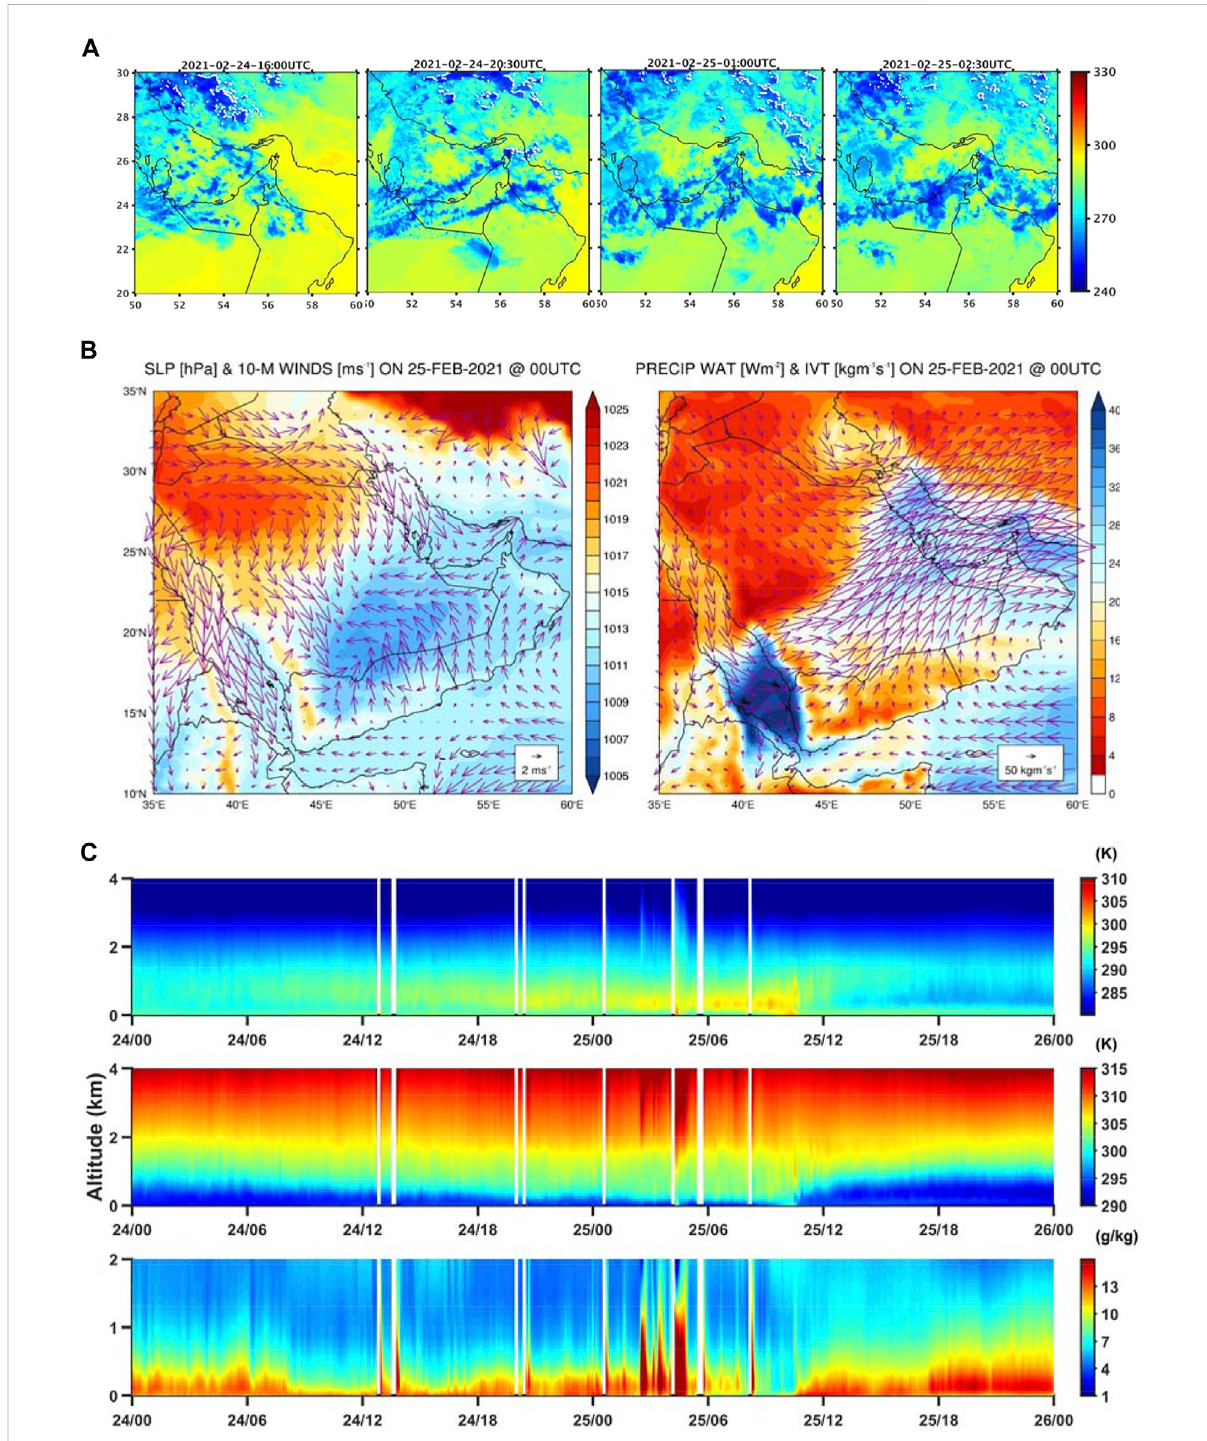
FIGURE 10 (A) IRBT (K) at selected times from 16 UTC on 24 February to 02:30 UTC on 25 February 2021 over the eastern Arabian Peninsula. (B) (left) sea- levelpressure(SLP;shading;hPa)and10-mwind(vectors;m s − 1 )and(right)precipitablewater(shading;kg m − 2 )andintegratedvapourtransport(IVT; vectors; kg m − 1 s − 1 ) at 00 UTC on 25 February 2021. (C) From top to bottom: Vertical pro fi les of air temperature (K), potential temperature (K), and speci fi chumidity(gkg − 1 )below4 kminaltitudefortheperiod24to25February2021derivedfromtheMWRmeasurements.Whitegapsdenote missing